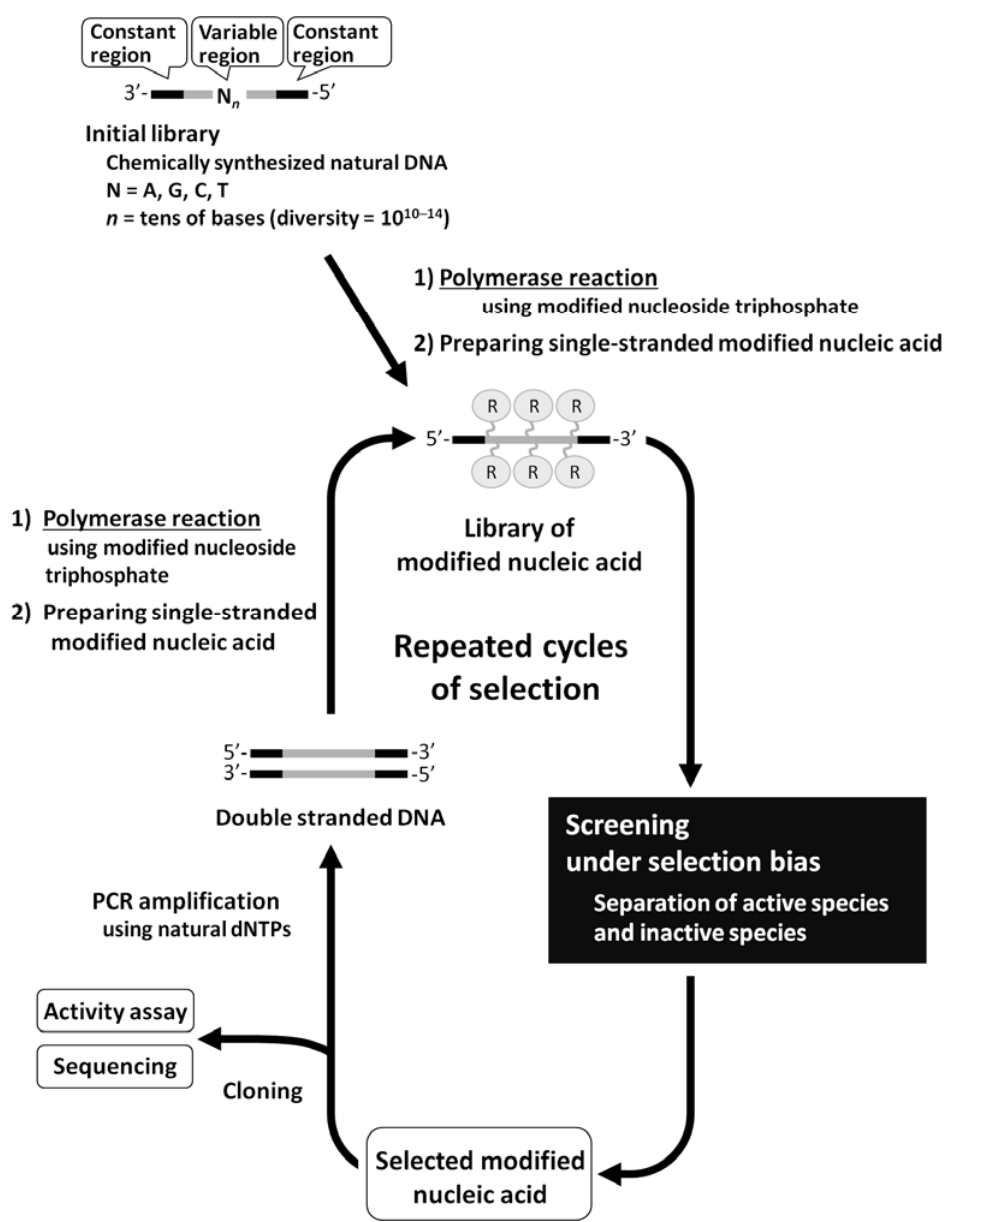
Figure 1. General scheme of in vitro selection using the library of modified